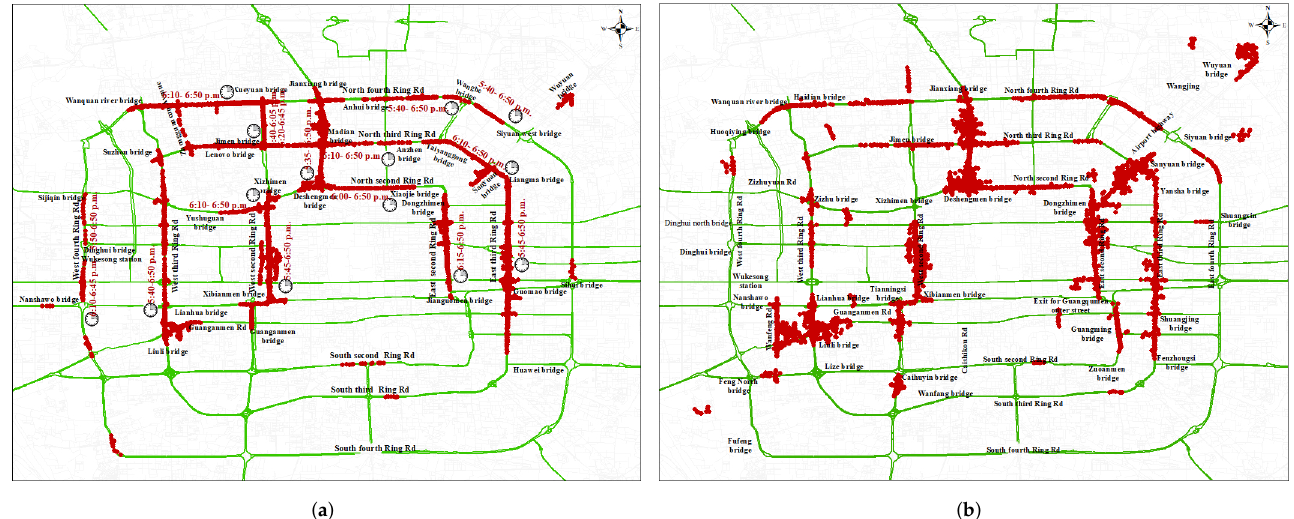
Figure 8. The discovered congested pattern during evening peak traffic hours on working days. ( a ) The LMCPs generated by our algorithm; ( b ) The swarm pattern generated by the CLUR algorithm.